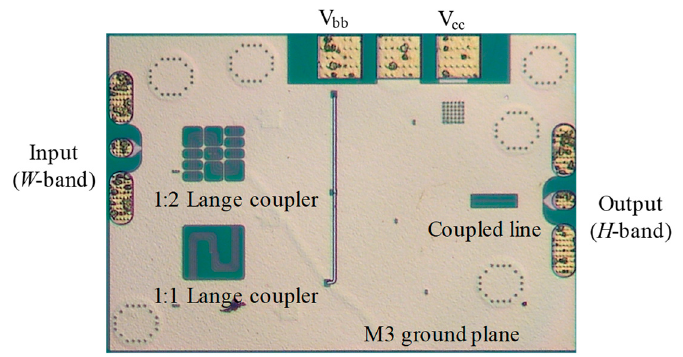
Figure 4. Photograph of the fabricated H -band frequency tripler integrated circuit (IC).